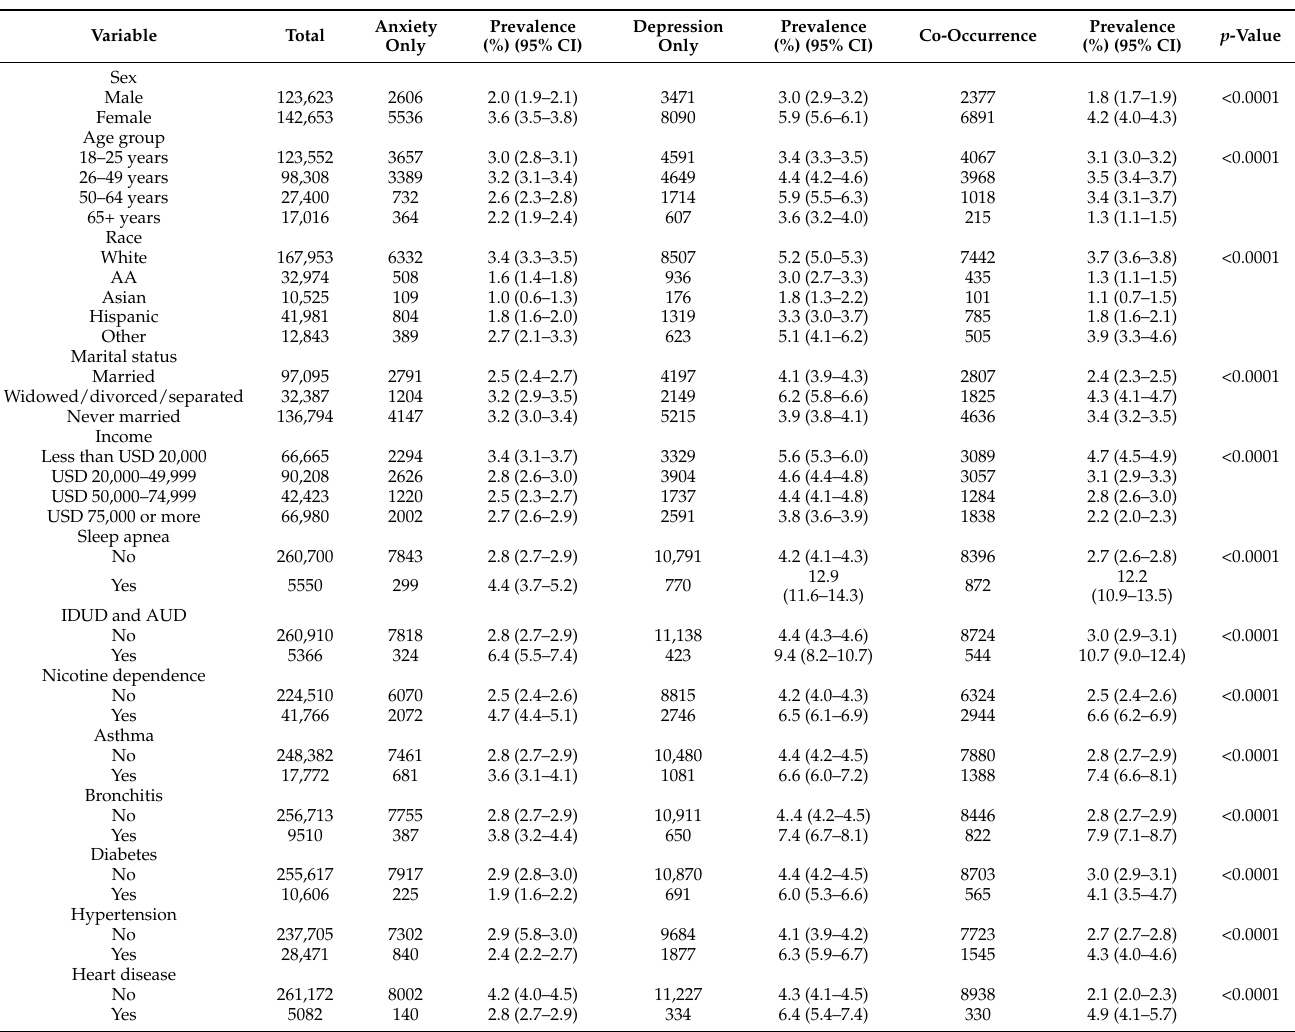
Table 3. Prevalence of anxiety only, depression only, and their co-occurrence